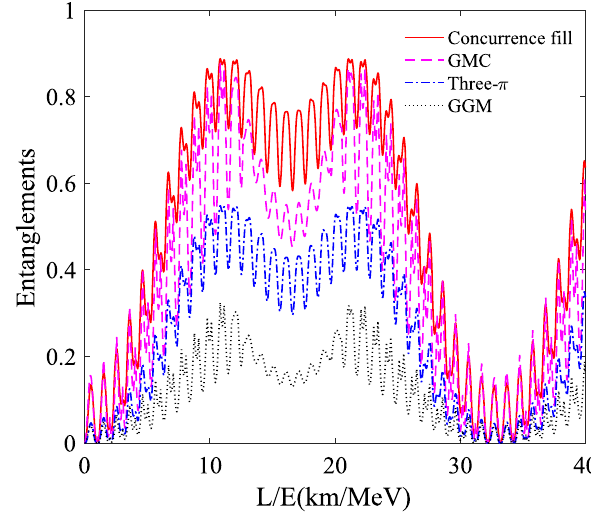
Fig. 2 The four kinds of multipartite entanglement measure, including GGM(blackdottedline),three- π (blue,dashed-dottedline),GMC(pur- ple, dashed line), and concurrence fill (red, solid line) for the electron antineutrino oscillation system √ 4 ( 5 − 1 )/ 9, 8 / 9, and 8 / 9, respectively, when all the oscil- lation probabilities are equal to 1 /